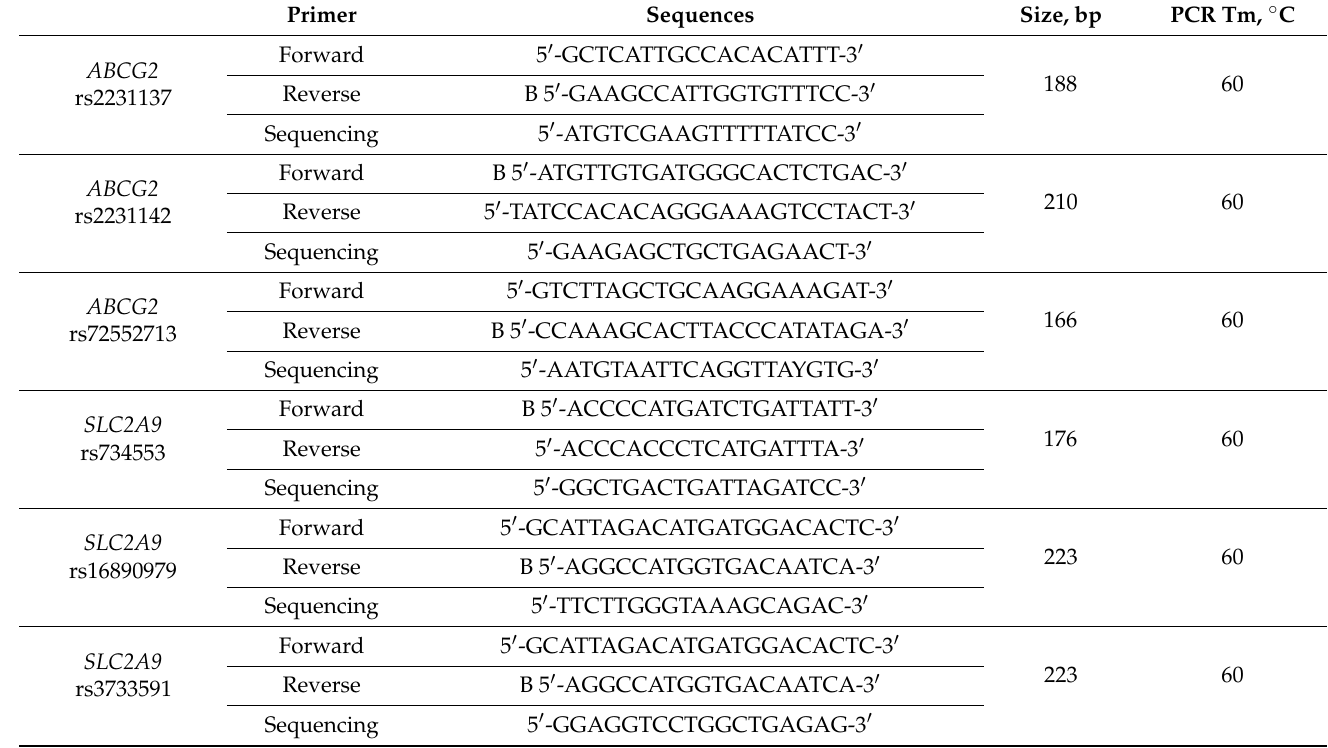
Table A1. Description of the oligonucleotide primers used for PCR and pyrosequencing for the detection of ABCG2 and SLC2A9 SNPs.